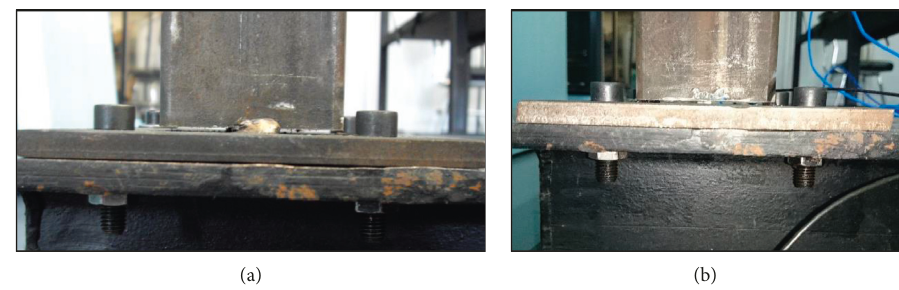
Figure 7: Detail of the weld bead along the long side (a) and short side